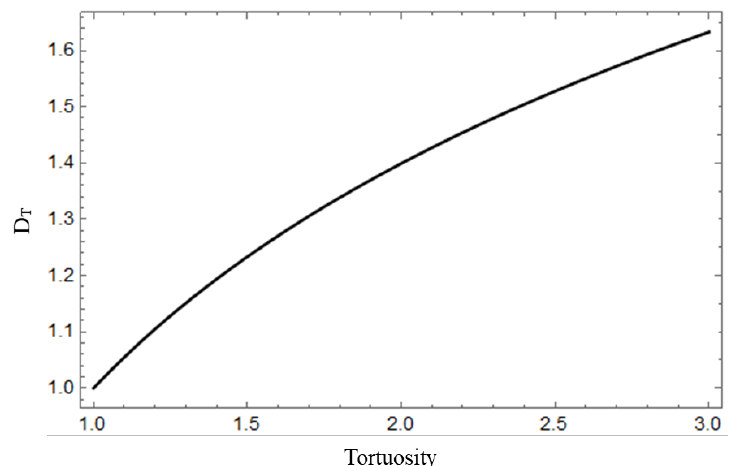
Figure 7. The variation of the tortuous fractal dimension with the tortuosity. According to Equation (11), the influence of pore diameter distribution on tortuous fractal dimension at different Φ min / Φ max can be calculated. As shown in Figure 8, we assume that the x axis at the bottom of Figure 8 maintains the maximum pore diameter of 1000 μm , and the x axis at the top of Figure 8 maintains the minimum pore diameter of 0.001 μm. Figure 8 shows the tortuous fractal dimension decreases with the de crease in Φ min / Φ max when the maximum pore diameter is 1000 μm. This due to the complexity of the tortuosity decrease with the increase in pore diameter distribution range. The increase in maximum pore diameter has little effect on the fractal dimension of tortuosity while the minimum pore diameter is constant.